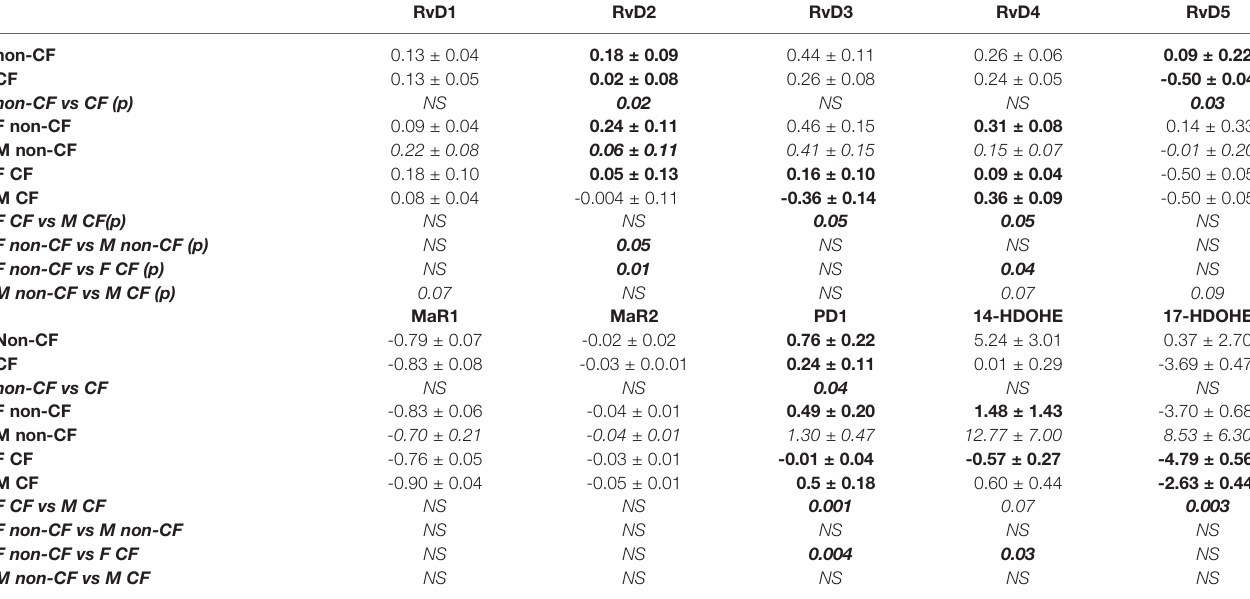
TABLE 3 | Docosahexaenoic acid (DHA) metabolites biosynthesis.